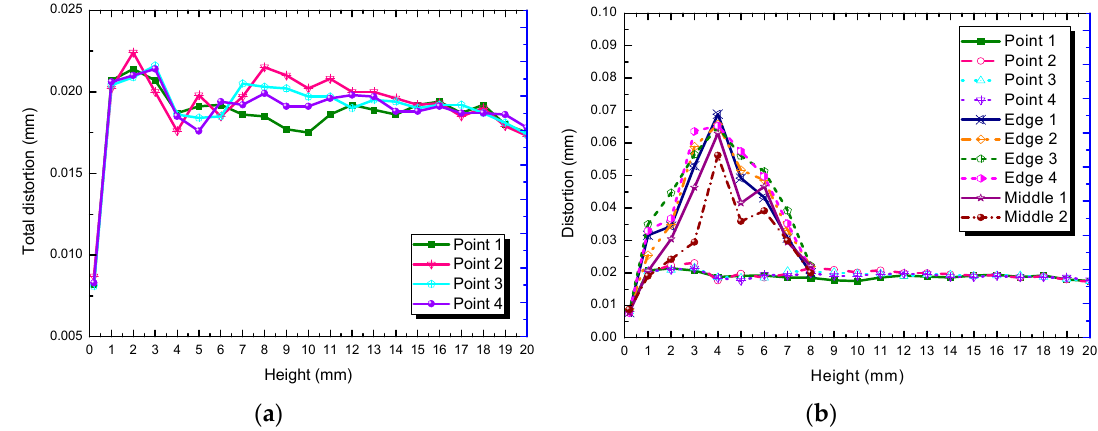
Figure 8. Distribution trend of thermal distortion: ( a ) water nozzle; ( b ) various locations.